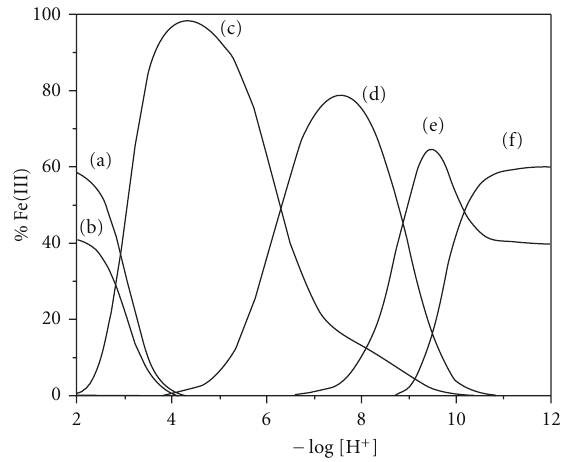
Figure 6: Interaction distribution curves of a natural melanin solution containing 0.00994 mmol of Fe(III) ions and 0.0370 mmol of melanin (40mg of natural melanin) at 25.0 ◦ C., where (a) = Fe(Ac) 2+ , (b) = Fe(Qi) 2+ , (c) = Fe(OH)(Cat), (d) =